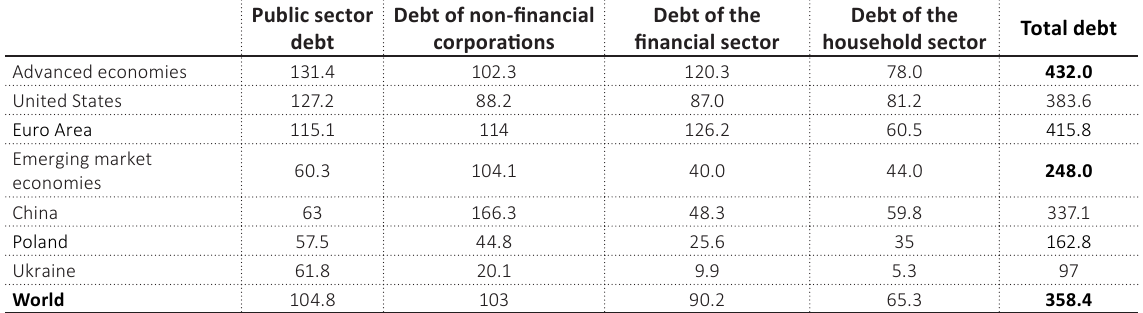
Table 2. Accumulated debt by sectors and countries (their groups) as a % of GDP at the end